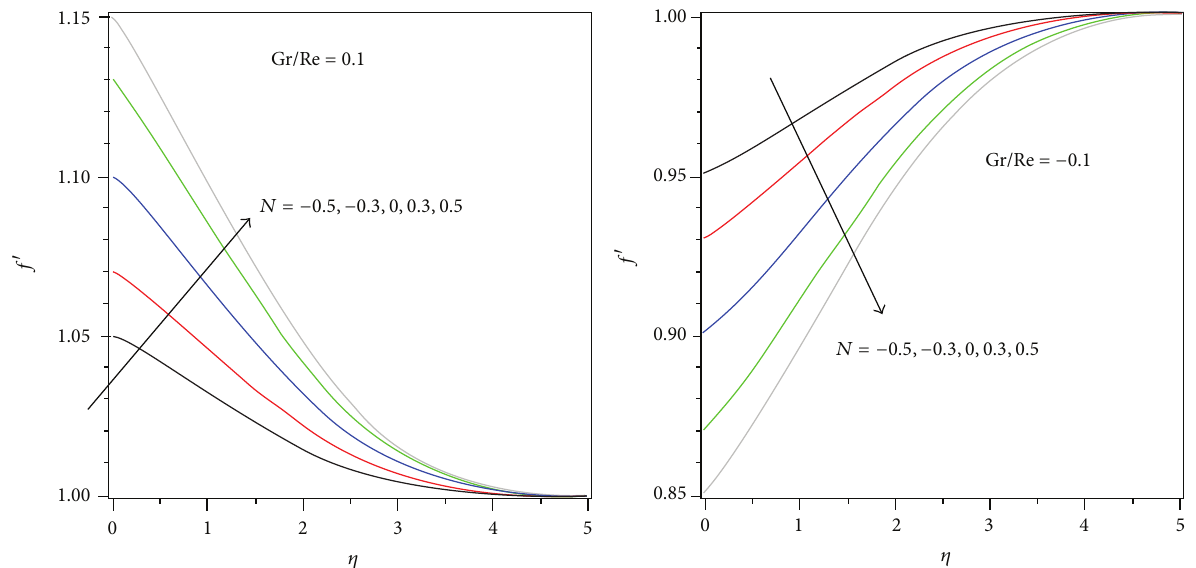
Figure 8: Velocity profile for both aiding and opposing external flows for different values of 𝑁,𝑀 = 2 , Df = 0.02 , Sr = 0.2 , and Le = 1.0 .